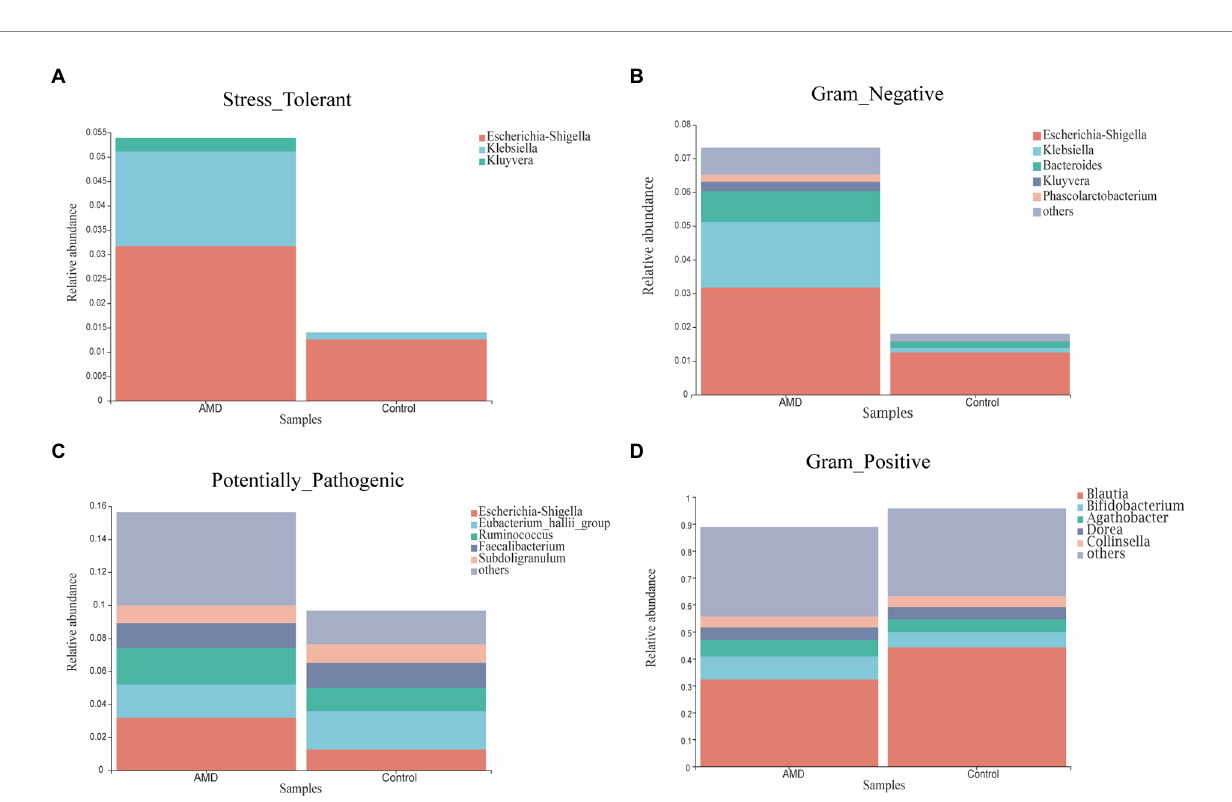
FIGURE 6 The relative abundance of microbial phenotypes in patients with AMD and controls. (A) Stress-Tolerant. (B) Gram-Negative. (C) Potentially-Pathogenic. (D)